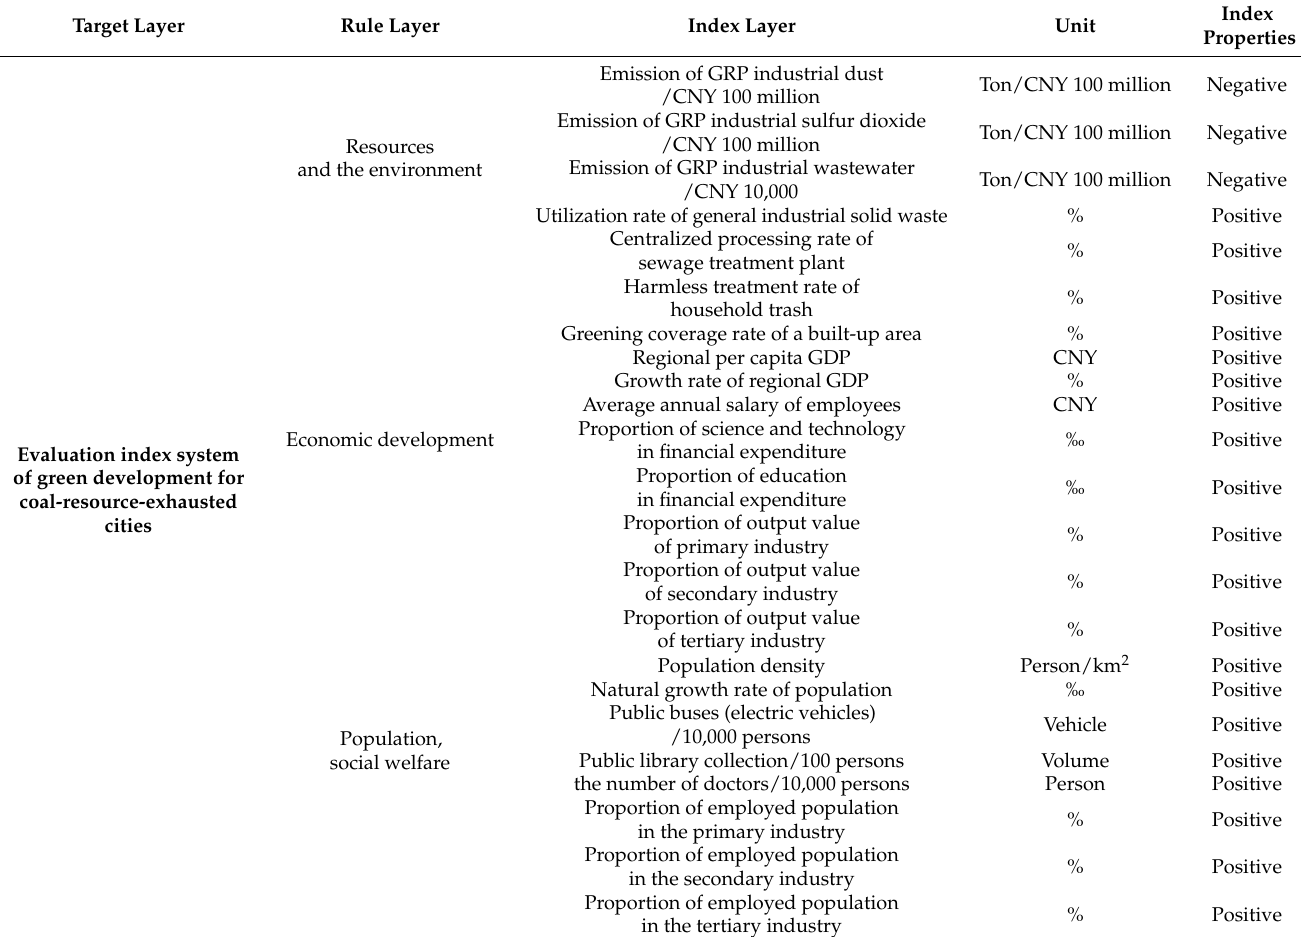
Table 5. Evaluation index system of green development for coal-resource-exhausted